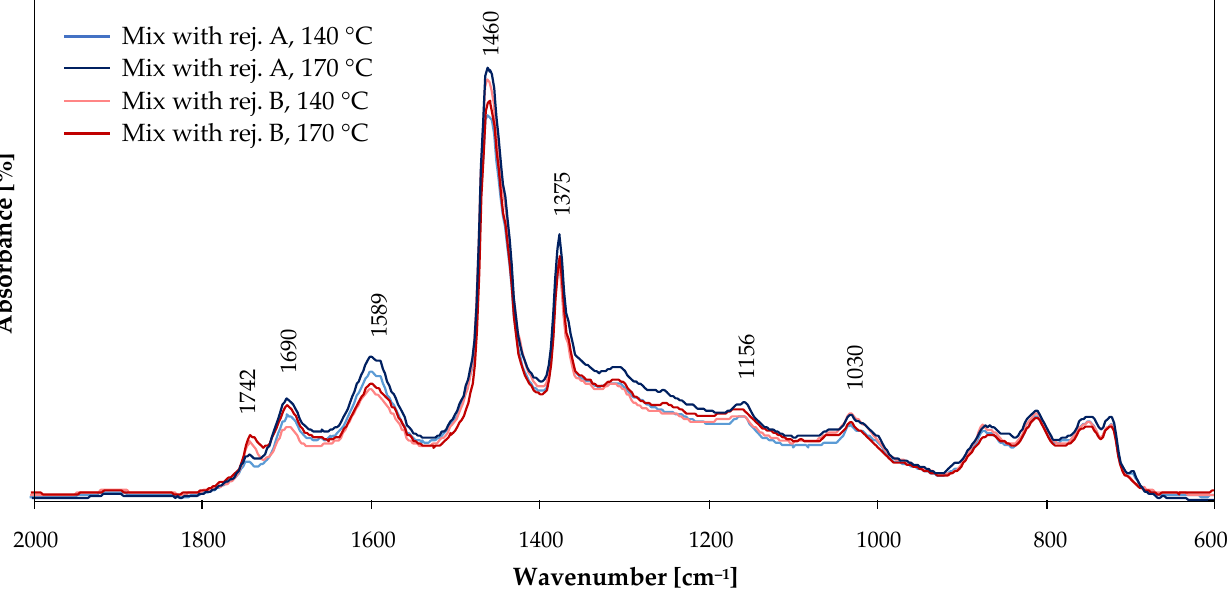
CO ; ( b ) Sulfoxide index I SO